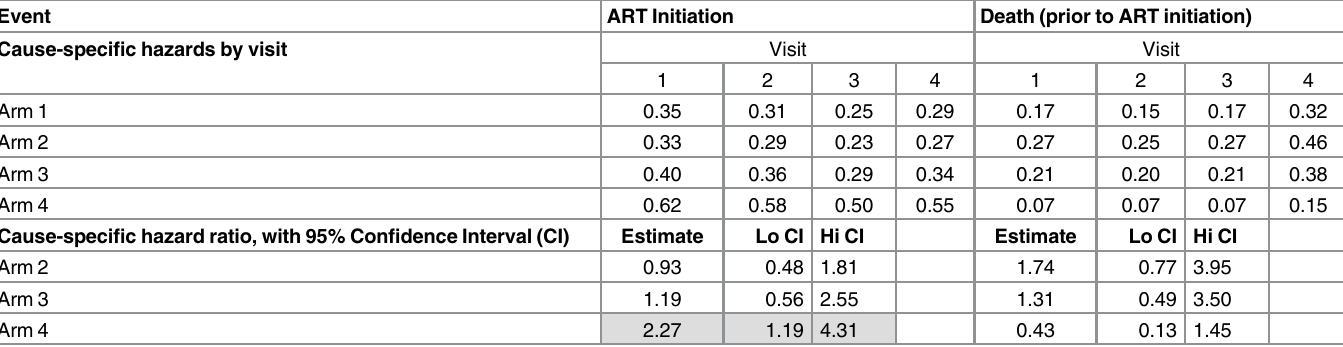
Table 3. Cause specific hazard (by visit), and hazard ratio of either initiating ART (target event), or dying prior to ART initiation (competing event) by trial arm. Arm 1 — Standard of care; Arm 2- Structural-level stigma intervention; Arm 3 — Individual-level intervention; Arm 4 — Both structural and individ- ual level